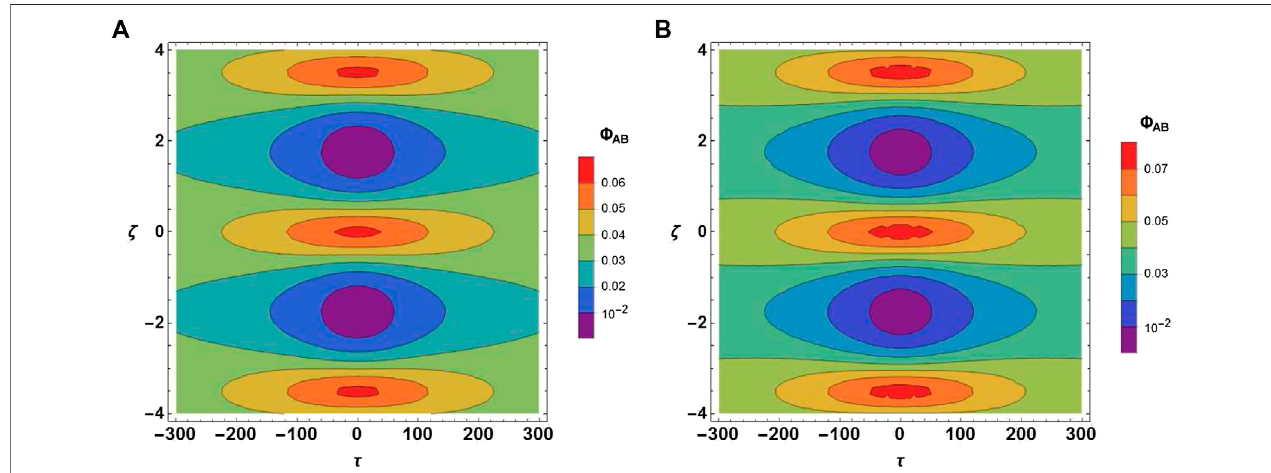
FIGURE 3 | The variation of DA Akhmediev breathers pro fi le in ζ - τ plane (A) for R (cid:1) 0 . 1 and (B) R (cid:1) 0 . 11 at fi xed values of α (cid:1) 0 . 1 and ρ (cid:1) 1 .